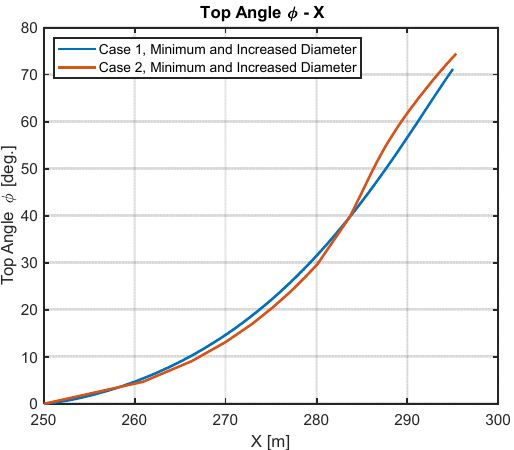
Figure 12. Total mooring tension at the fairlead as a function of horizontal distance from the an- chor to the buoy.